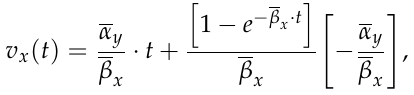
Figure 11. Schematic of the alternating arrangement of the dislocations of the GBs is separated into two planar SGBs under the deviatoric deformation and generates new deformed grain 2 and 4 with orientation θ 2 and θ 4 , respectively. More detail snapshots for evolution of the dislocation of the SGB can be seen in Reference [55].